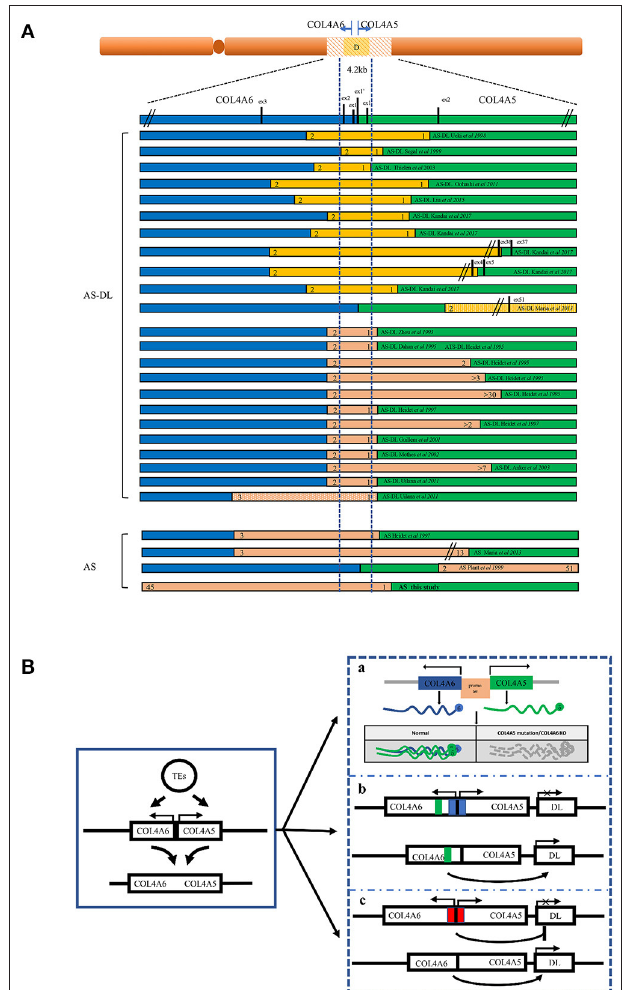
FIGURE 7 | Schematic overview of the reported deletions within COL4A5 and COL4A6 and the models of the mechanism leading to AS-DL. (A) A summary of reported AS or AS-DL cases caused by contiguous deletion of COL4A5 and COL4A6 genes. (B) A schematic diagram of the mechanism of AS with DL caused by contiguous deletion of COL4A5 and COL4A6 genes. a: Absence of α 5 (IV) and α 6 (IV) collagen chain. The absence of the α 5 (IV) collagen chain may change the structure of the ECM, which binds with the α 5 (IV) collagen chain. The deregulation of cellular signals secreted from ECM may favour the proliferation of smooth muscle cells, leading to the development of DL. b: The silencer model in AS-DL. Deletion of the silencer element activates the gene involved in DL. c: The insulator model in AS-DL. Deletion of the insulator element activates the distal enhancers and/or neighbouring genes involved in